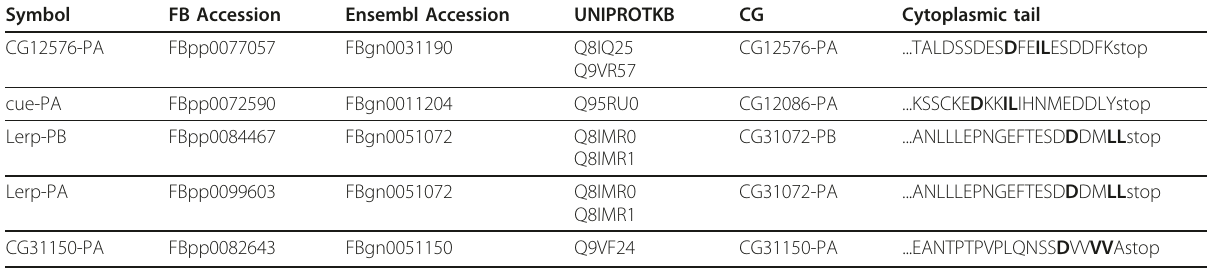
Table 1 Type I membrane proteins with GGA sorting